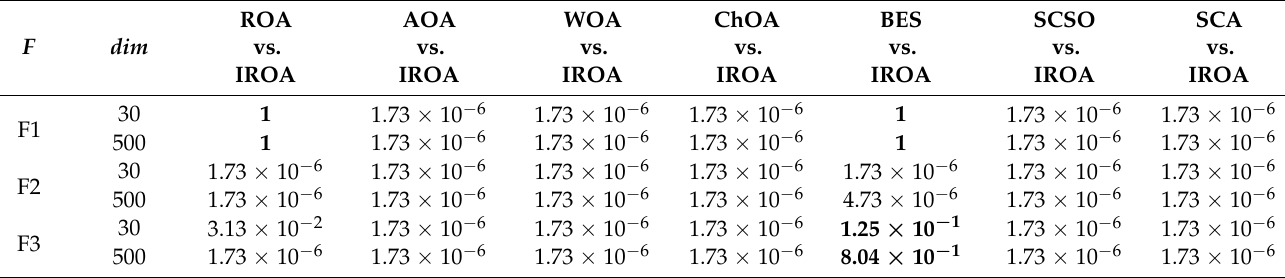
Figure 7. This is a figure. Schemes follow the same formatting. Table 4. Experimental results of Wilcoxon rank sum test on 23 standard benchmark